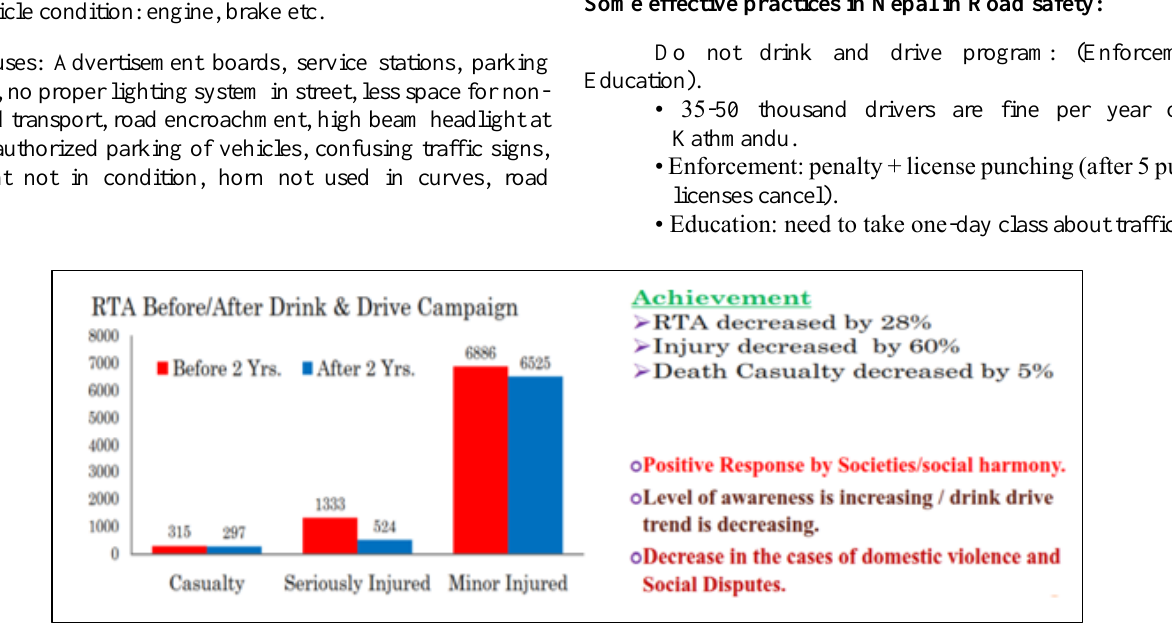
Figure 4: Comparison of two years’ data on drink and drive